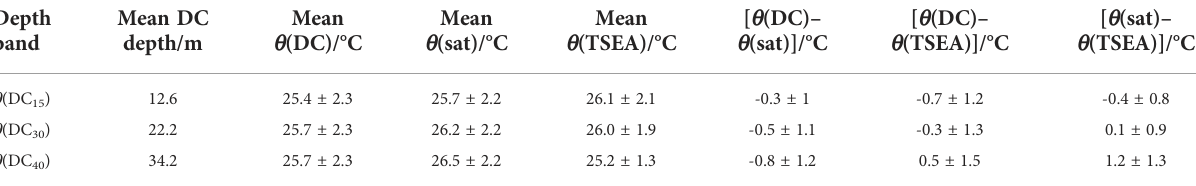
TABLE 4 Mean DC depth, temperature and bias by depth band for q (DC), q (sat) & q (TSEA).